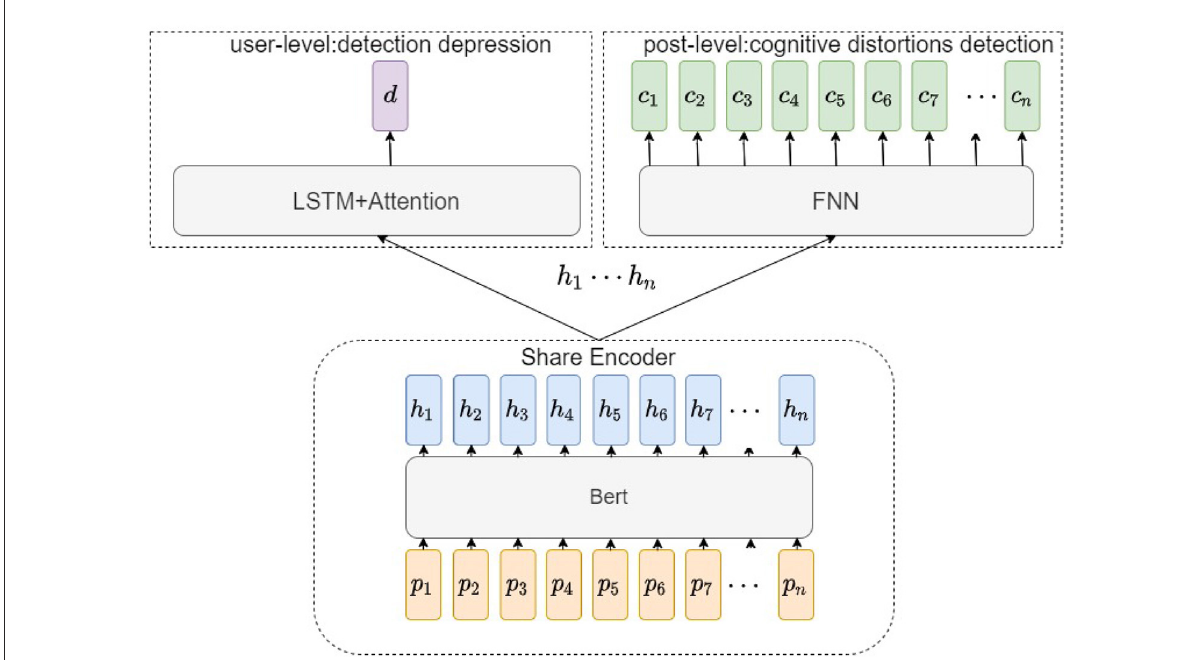
FIGURE3 This is our model’s structure. Our model uses user posts as input and produces two outputs, cognitive distortion predictions for posts vs. depression predictions for